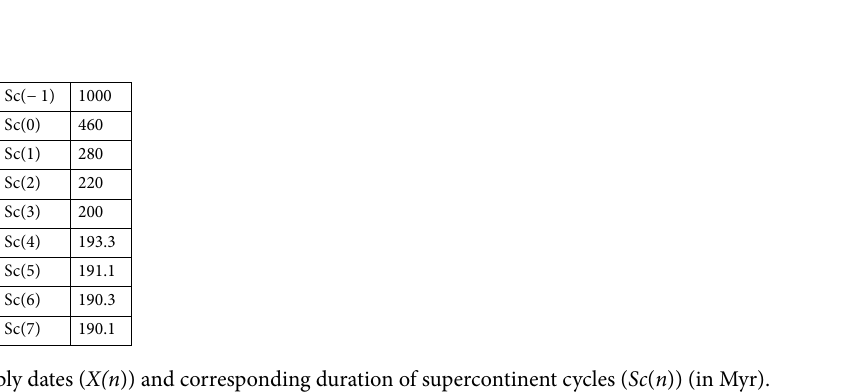
Figure 1. Chronological scale showing the different supposed supercontinent assemblies based on the literature (red stars denote the timing of assemblies whereas ages show ranges of assemblies). Based on the literature, 4 supercontinents can be recovered named Columbia, Rodinia, Gondwana and Pangea, whereas Ur and Kenorland represent possible Archean supercontinents or supercratons. Gyr refers to giga years whereas Myr refers to million years. The cyclicity represents a duration in Myr. The references are listed in the research article.